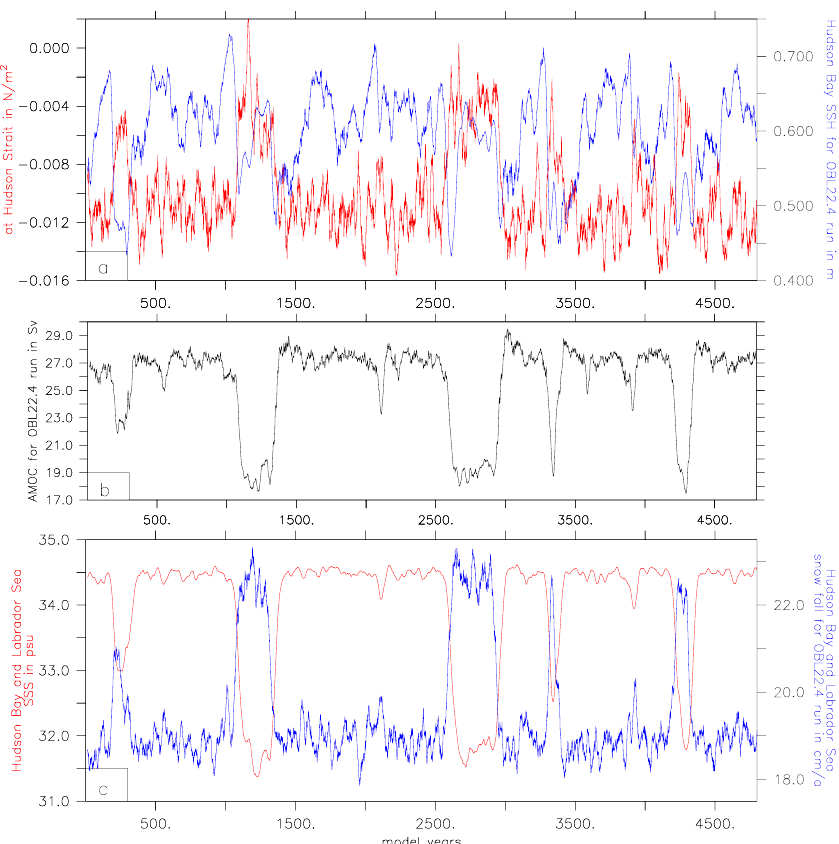
Fig. 4. Timeseries of variables for OBL22.4 run: (a) meridional wind stress at Hudson Strait (80 ◦ W:70 ◦ W, 60 ◦ N:70 ◦ N) (red) in N/m 2 and Hudson Bay (100 ◦ W:75 ◦ W, 52 ◦ N:70 ◦ N) sea surface height in m (blue) for OBL22.4 run. (b) AMOC in Sv for OBL22.4 run for comparison. (c) SSS in psu (red) and snow fall in cm/a (blue) averaged over Hudson Bay and Labrador Sea (100 ◦ W:45 ◦ W, 50 ◦ N:70 ◦ N) for OBL22.4 run in Sv. A running mean of 25years was applied for all